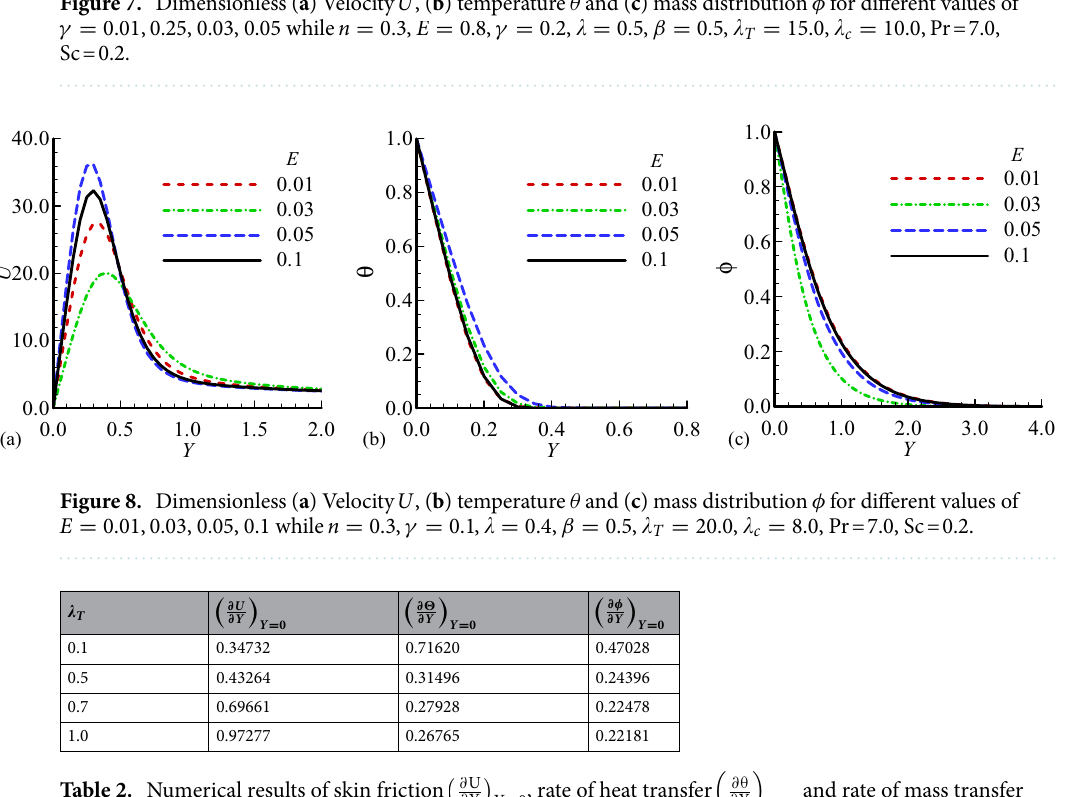
Table 2. Numerical results of skin